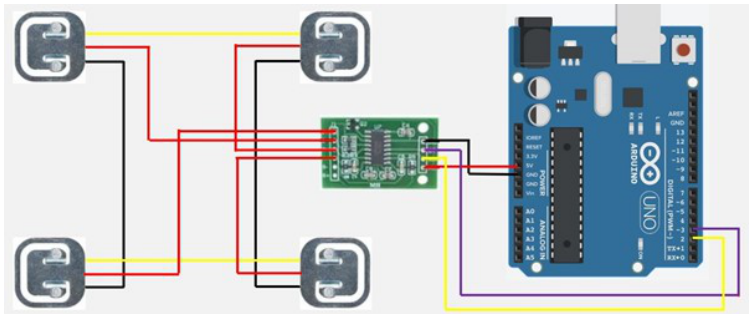
Figure 20. Schematic of the load-cells circuit.